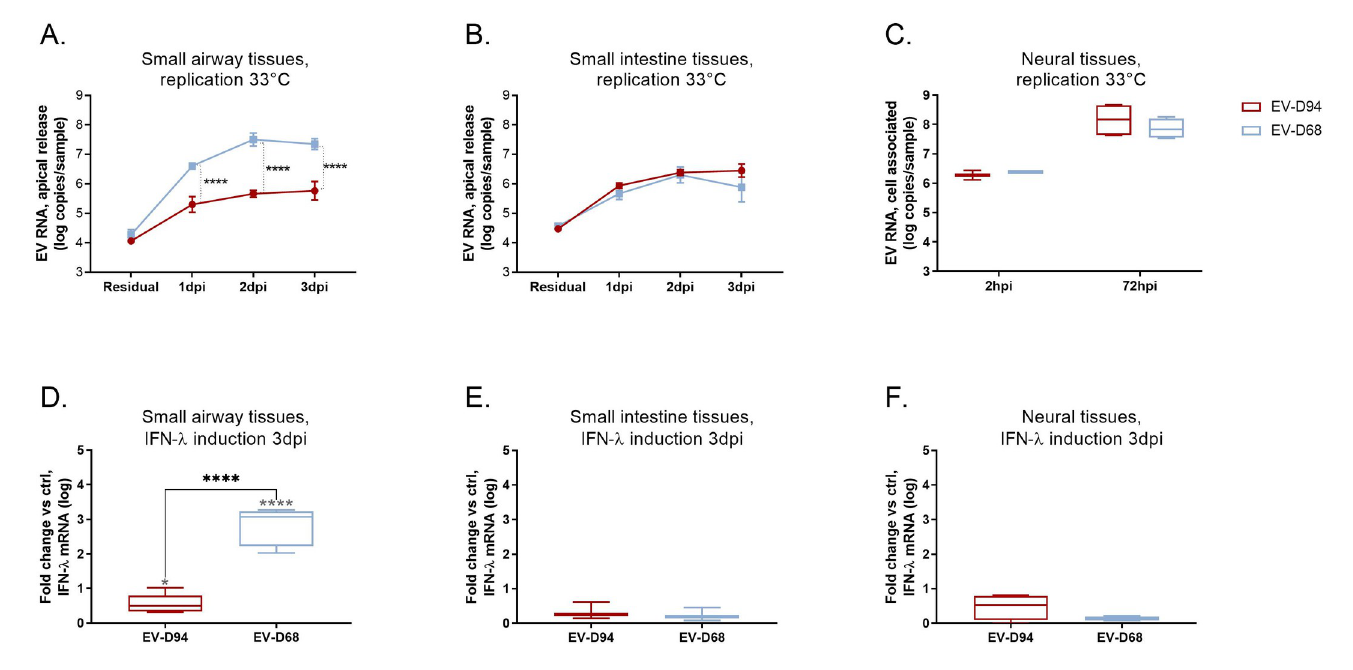
Fig 1. EV-D68 and EV-D94 tissue tropism (A-C) and IFN- λ induction (D-F) . Tissues were inoculated with equivalent multiplicity of infection (MOI) of EV-D94 and EV-D68 and replication was assessed by RT-qPCR. Respiratory (A) and intestinal (B) tissues were inoculated apically and washed 3 times at 3 hours post-infection (hpi). Residual virus was quantified after the washes. Apical samples were then collected at the indicated time points for viral RNA quantification. Neural tissues (C) were incubated with viral suspension and viral RNAs extracted from tissue lysate after inoculation (2hpi) and 3 days later were compared. IFN- λ mRNA levels (D-F) were measured in tissue lysates collected 3dpi and fold change relative to non-infected tissues was calculated with the ΔΔ Ct method. Significance between viruses is shown with black stars. In D, E and F, significance relative to mock-infected is shown with grey stars.